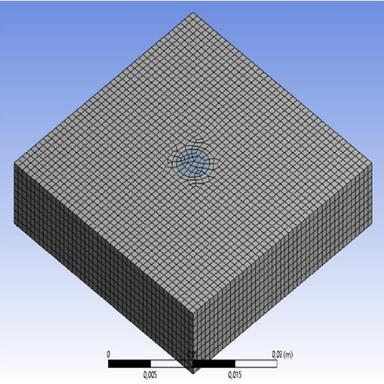
3D model created in Ansys.